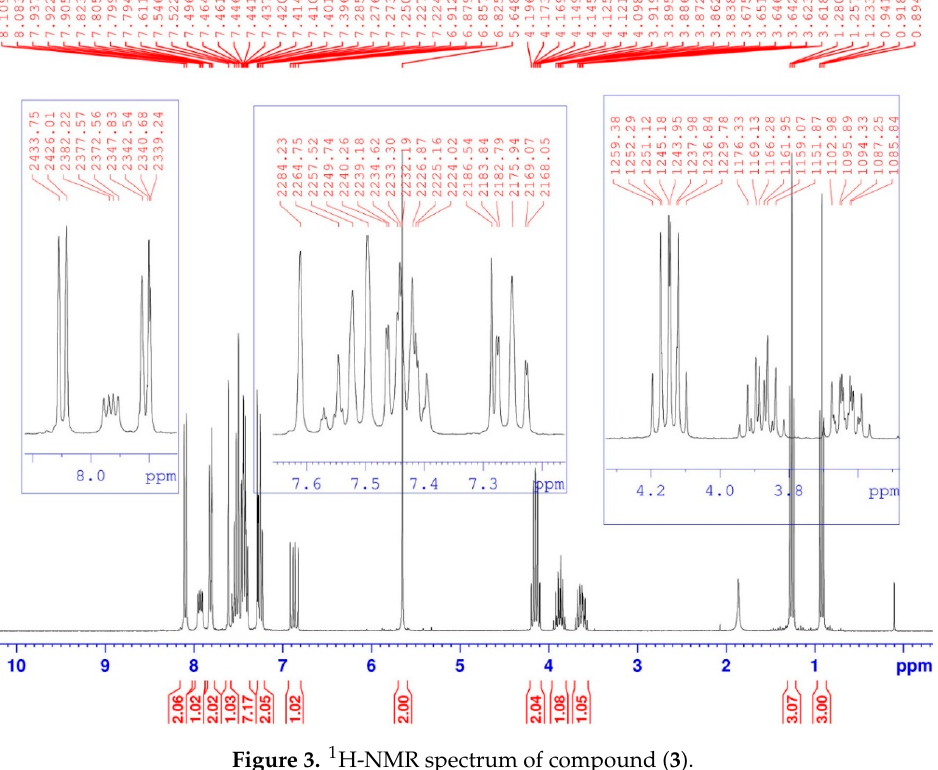
Figure 3. 1 H-NMR spectrum of compound ( 3 ).